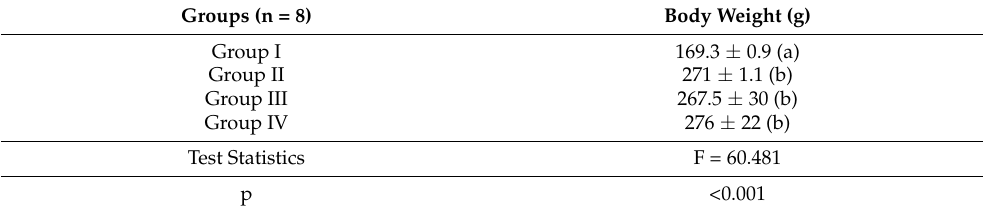
Table 1. Average values of body weight of rats by groups.